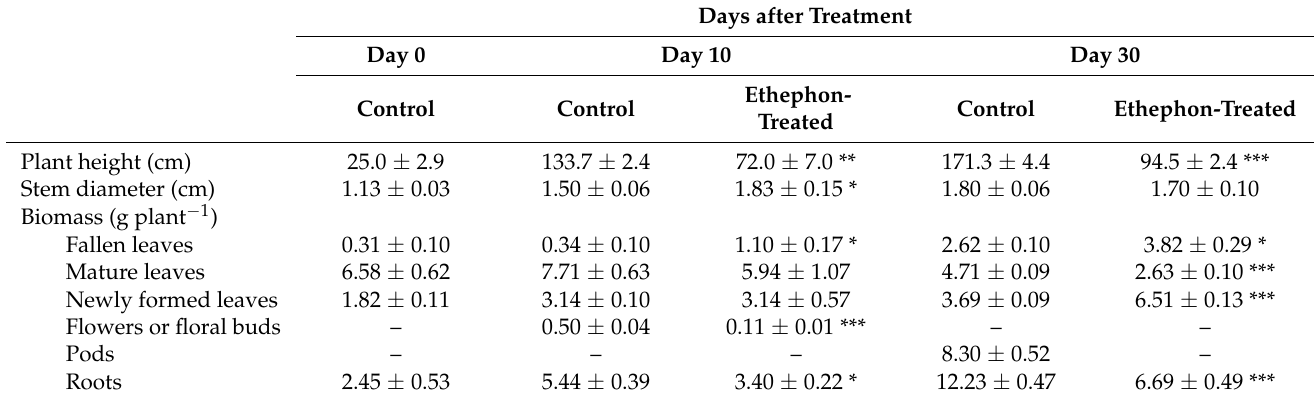
Table 1. Plant height, stem width, and biomass of different tissues for the control and ethephon-treated plants before the ethephon application (day 0), at the end of ethephon application for 10 days (day 10), and an additional 20 days after the treatment (day 30). Data are presented as mean ± SE ( n =